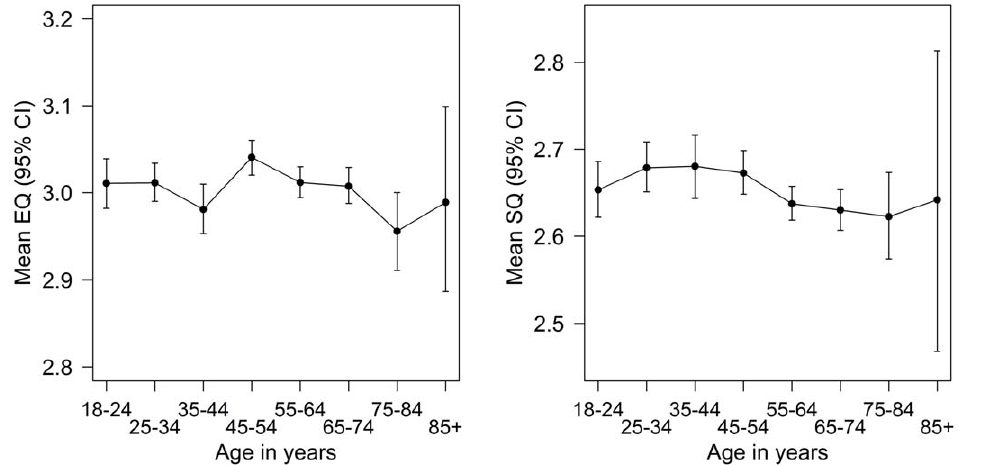
Figure 9. The mean EQ (left panel) and SQ (right panel) scores for different age bands. The means could potential range from 1–4 so these graphs show only a small part of this